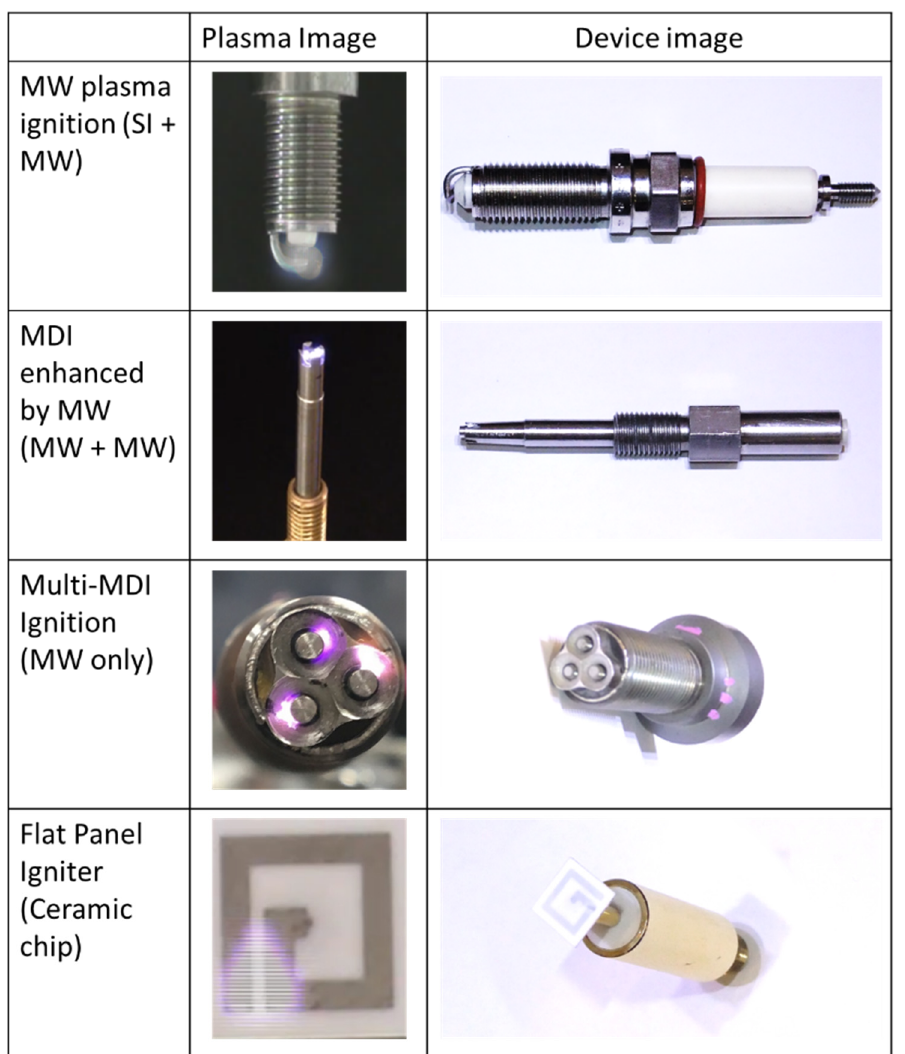
Figure 6. Comparison of spark plug, microwave discharge igniter (MDI), and flat panel igniter (FPI). There are multiple variations of the ignition process spark plug and MDI depending on the energy input.